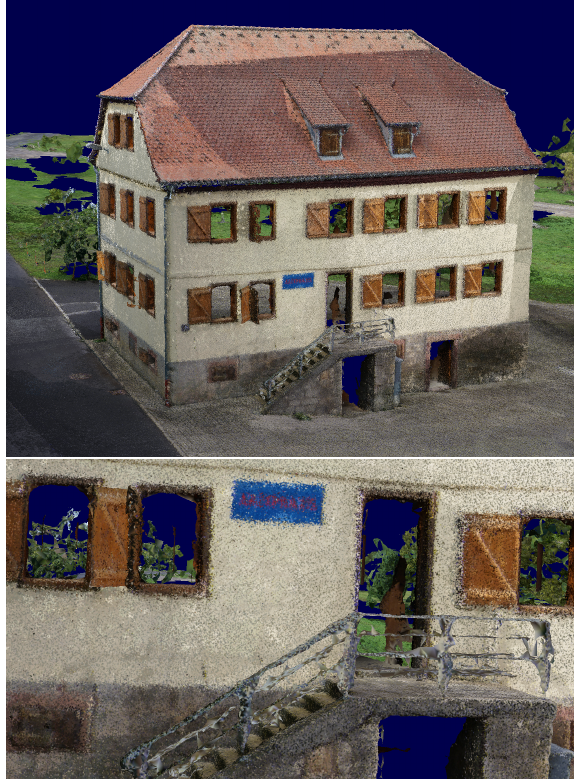
Figure 3. Reconstructed dense point cloud with surface mesh containing more than 25 million 3D points and more than 50 mil- lion triangles. This result is not the highest resolution we can obtain, but we are still able to visualise this model. The lower part shows a close view, where details as the sign left of the door or the handrails of the stairs can be recognized.